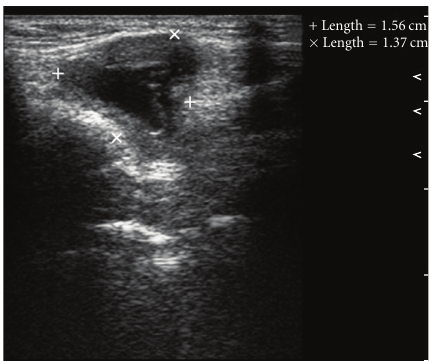
Figure 2: Longitudinal grey-scale ultrasound in the left subman- dibular region shows an anechoic TDC with thick wall.